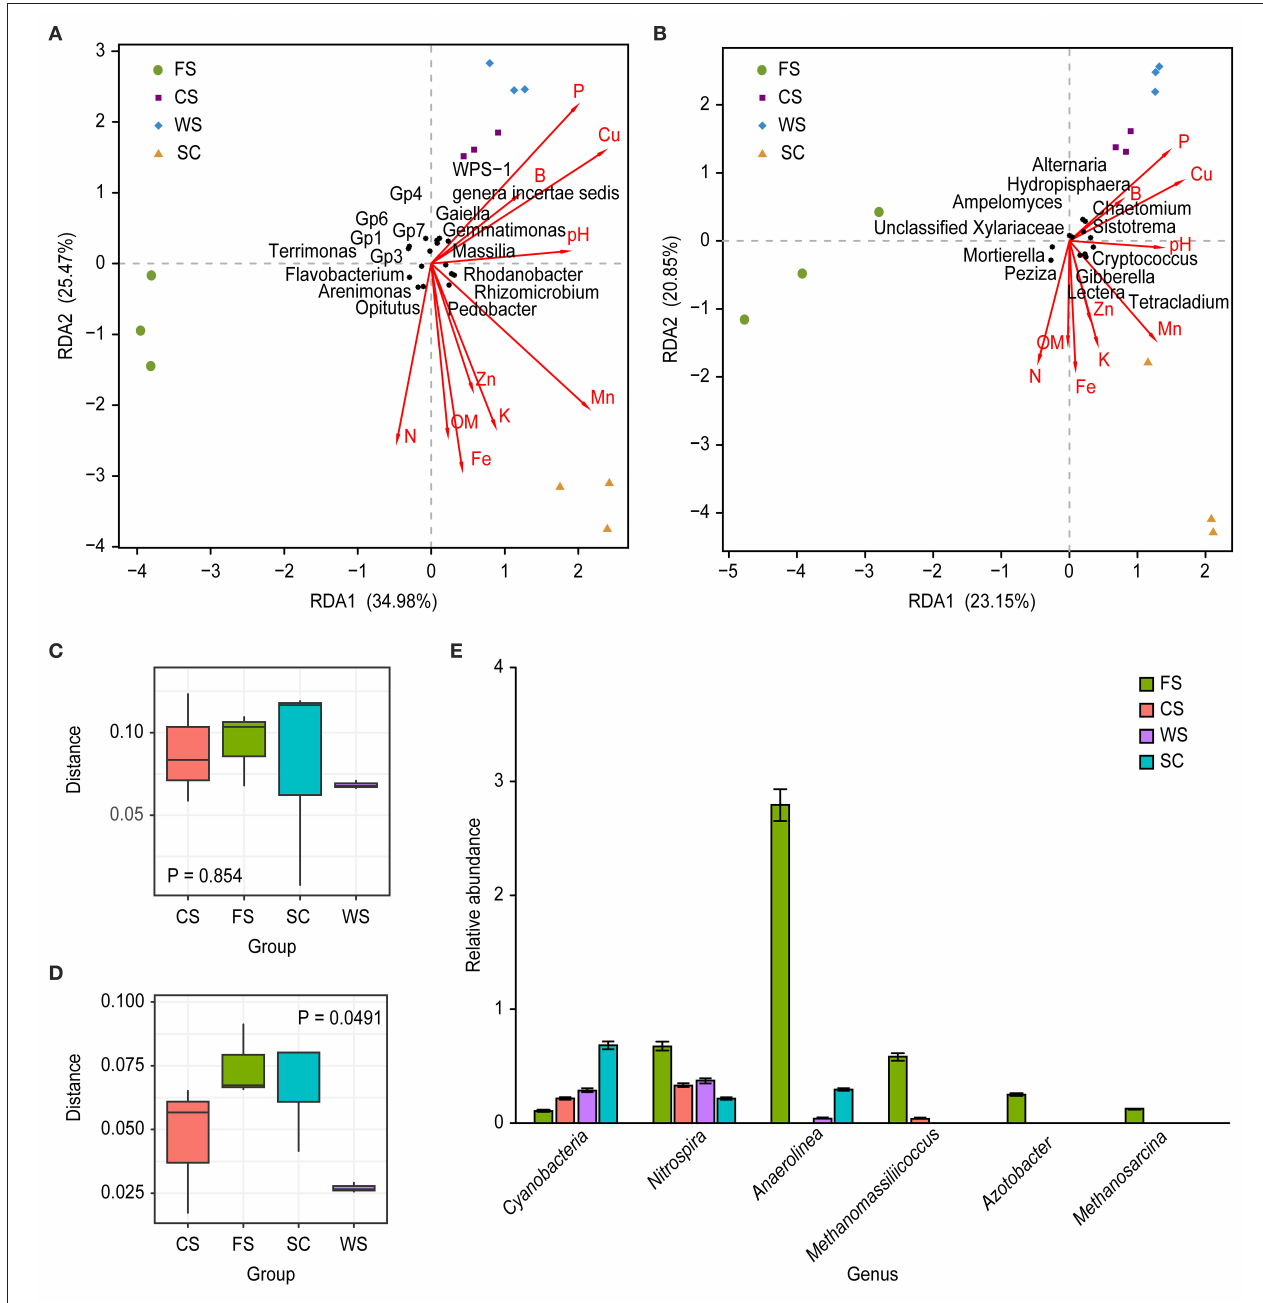
FIGURE 4 | Microbial community differences. (A,D) : bacteria, (B,C) : fungi. (A,B) : RDA. (C,D) : body figure. (E) : relative abundance of genera. RDA: The image indicates multiple physico-chemical properties and a sample/microflora RDA analysis diagram. The arrows represent different physico-chemical properties. A longer ray indicates a greater influence of the soil physico-chemical properties. For each sample, the angle between the center and the arrow represents the relationship between the sample and soil physico-chemical properties (acute angles show positively correlated relationships, obtuse angles indicate negatively correlated relationships, and rectangles indicate irrelevance); the points in different colors represent different samples. The different samples are perpendicular to the arrows for different physico-chemical properties. Closer projection points indicate that the soil physico-chemical properties are more similar in the sample, and the value of the physico-chemical properties increases along the direction of the arrow. The horizontal coordinates in the above C and D images represent different cropping system, and the vertical coordinates indicate the distance between the sample groups. Blue boxes: SC; green boxes: FS; orange boxes: and CS; black boxes: WS. The P - values indicate the differences between the groups. The horizontal coordinates in the unit E graph represent different classifications. The ordinate values represent the relative abundances; the relative abundance of Cyanobacteria and Nitrospira is expressed in %, whereas the quantitative value of the relative abundance times 100 is shown for the other genera. SC, soybean continuous cropping system; FS, fallow-soybean cropping system; CS, corn-soybean rotation cropping system; and WS, wheat-soybean rotation cropping system.